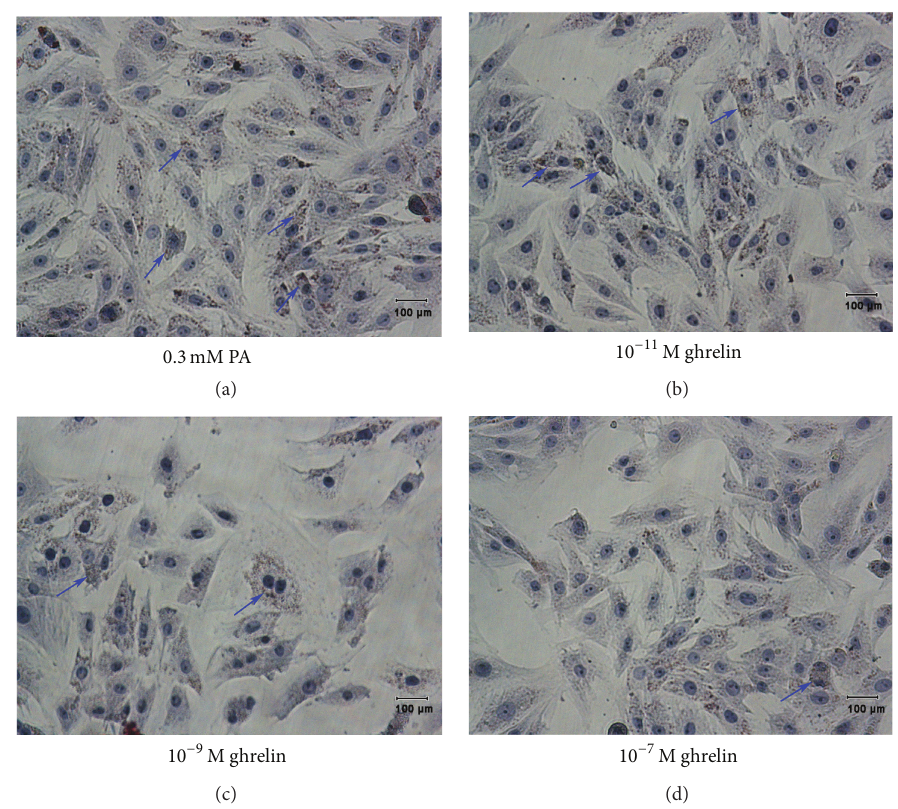
Figure 2: Effects of acylated ghrelin on palmitic acid- (PA-) induced triglyceride (TG) accumulation in primary cultured rat myoblasts. Rat myoblasts in the high fat group were cultured with 0.3 mM PA (containing 0.5% BSA) for 12h (a). In the three intervention groups, acylated ghrelin at 10 −11 M (b), 10 −9 M (c), or 10 −7 M (d) was added under high fat conditions for 12 h. TG accumulation (blue arrows) was determined by Oil-Red-O staining (scale bar: 100 𝜇